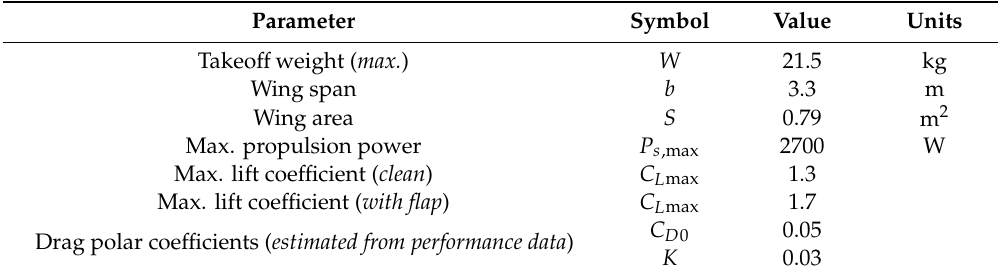
Table 2. Aircraft data for sample